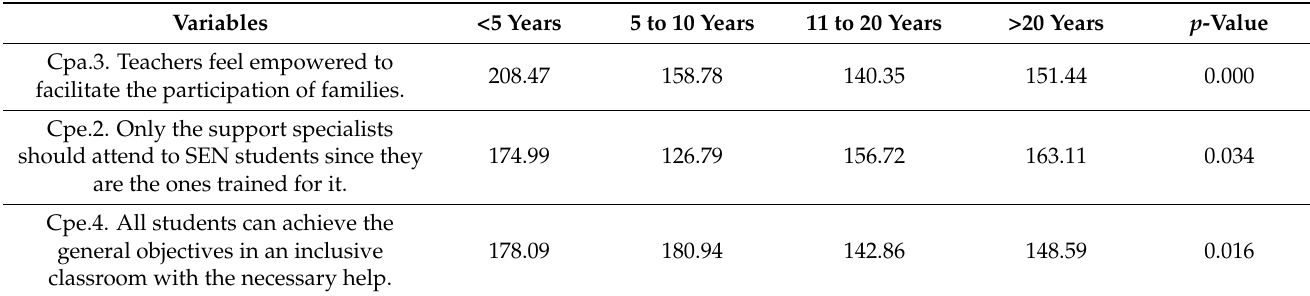
Table 6. Kruskal-Wallis analysis according to teaching seniority.